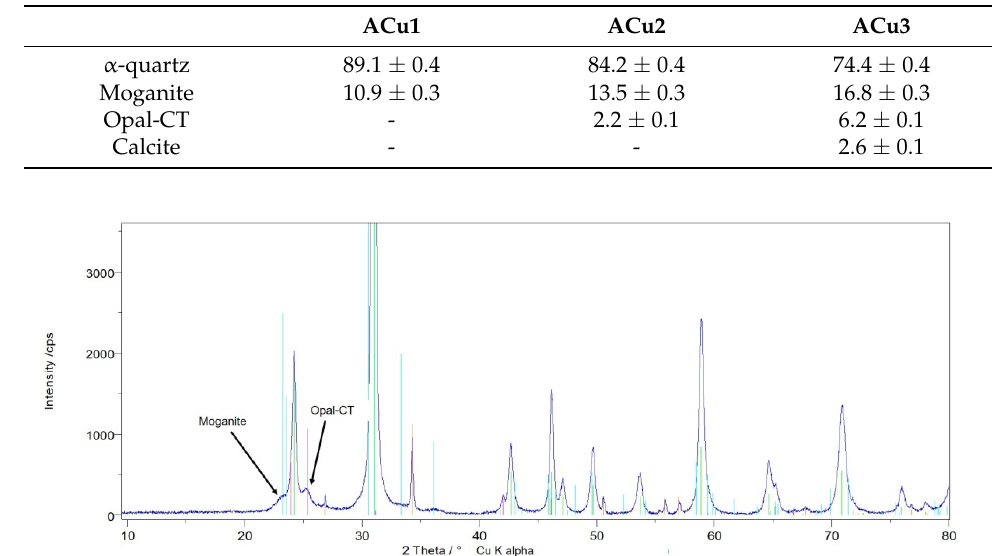
Figure 5. The X-ray diffraction pattern of sample ACub3 (powder sample, background corrected); search-match results in stick patterns: magenta, opal-CT (PDF 00-066-0177); light blue, moganite (PDF 01-073-2991); green, quartz (PDF 01-070-3755); red, calcite (PDF 01-083-0577). The arrows point to the characteristic broad maxima of moganite and opal-CT.